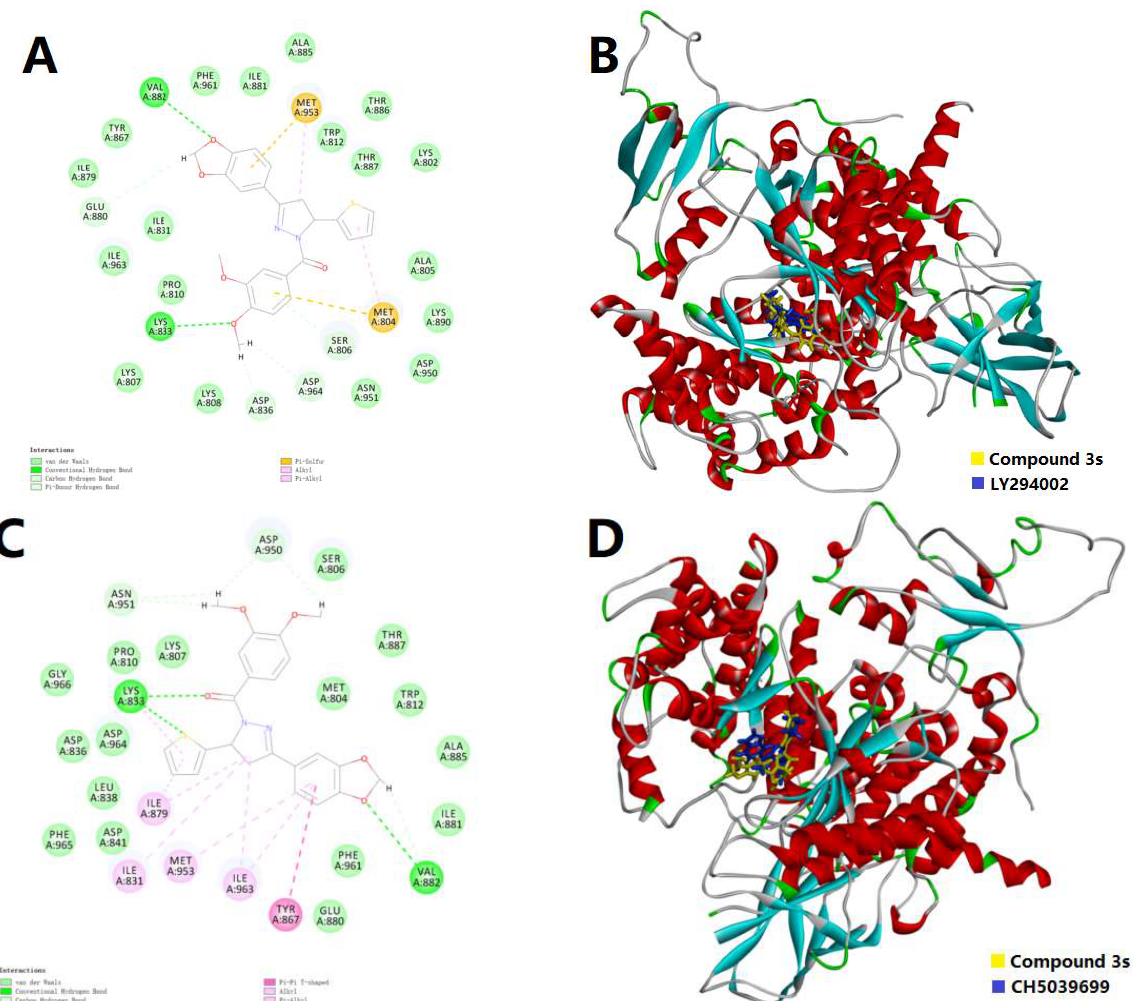
Figure 3. ( A ) The 2D docking model of compound 3s into PI3Kα; ( B ) The 3D docking models of 3s and LY294002 into PI3Kα; ( C ) The 2D docking model of compound 3s into PI3Kγ; ( D ) The 3D dock- ing models of 3s and CH5039699 into PI3Kγ. The H-bonds were displayed as green dotted lines. The π-related interactions were shown as pink (π-π or π-alkyl) and yellow (π-sulfur) dotted